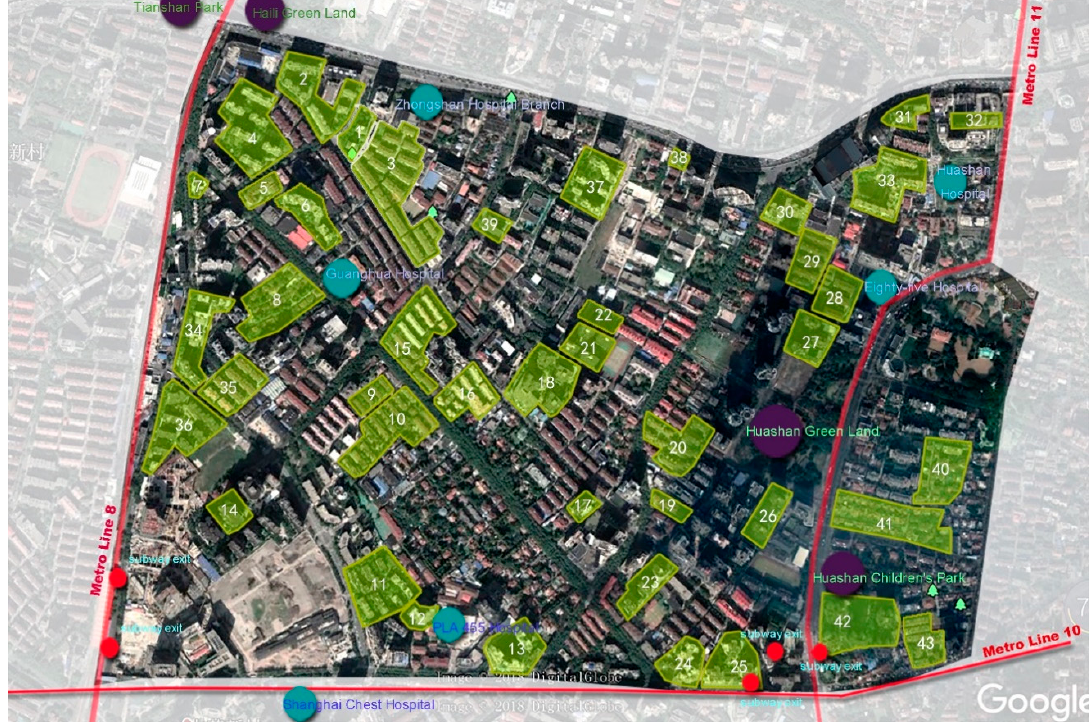
Figure 3. Map of the community sample (source: based on Google Maps, drawn by the author).